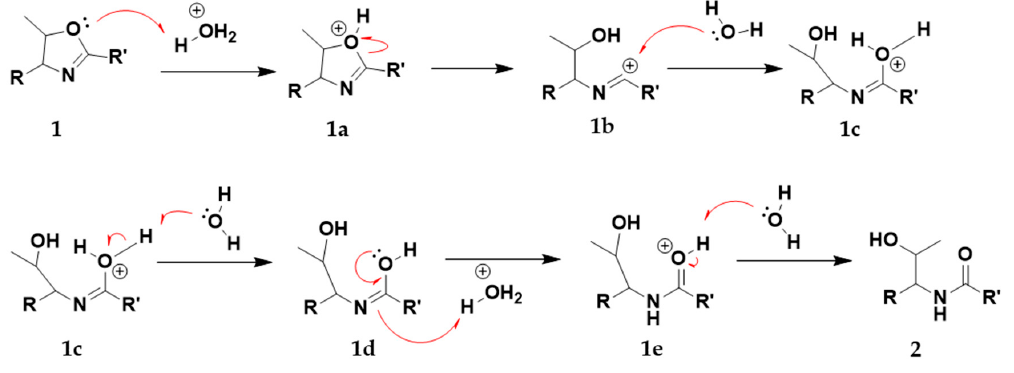
Figure 5. The proposed acid-catalyzed degradation reaction of the central methylated oxazoline ring of 1 , turning 1 into 2 via intermediates 1a to 1e